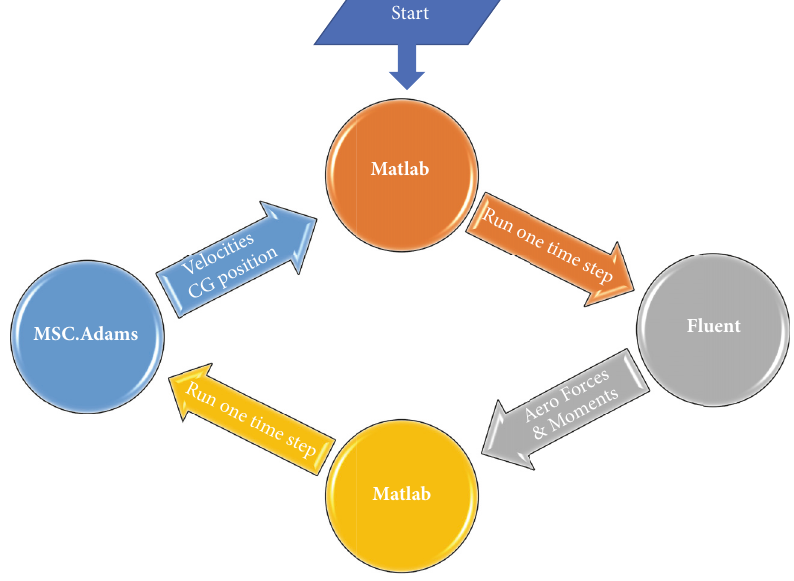
Figure 18: Scheme of the connections of the programs and exchange of